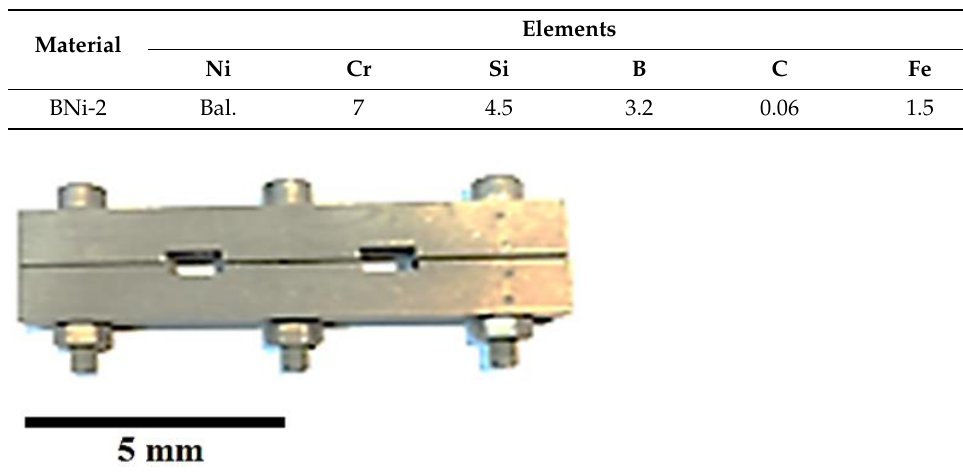
Figure 1. The fixture used to transient liquid phase bond the SFSS 446 and MSS